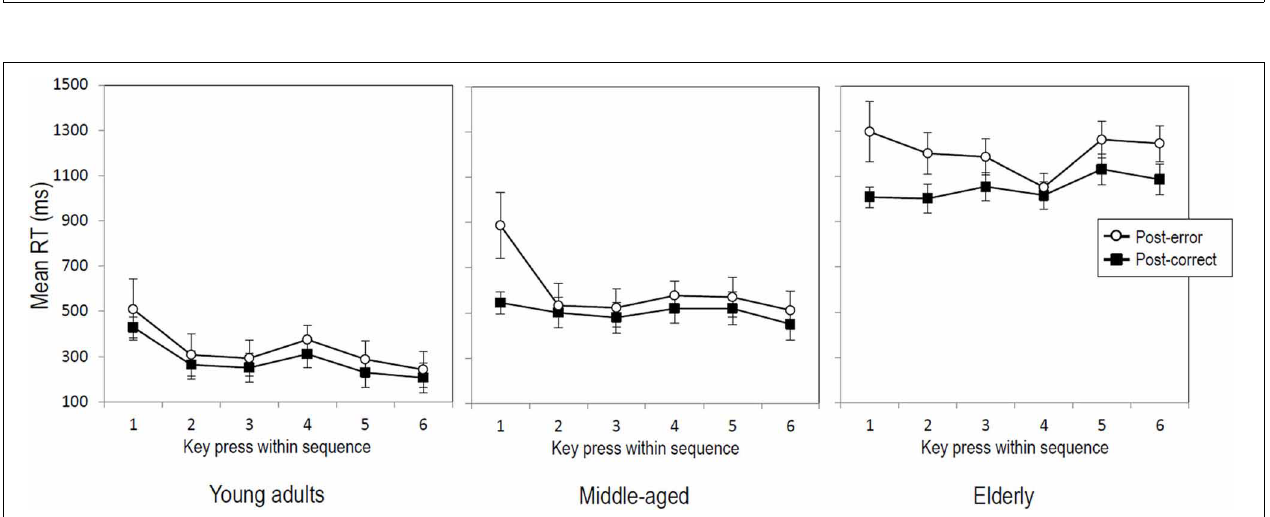
some age groups, F ( 2 , 61 ) = 4 . 35, p < 0 . 05, η 2